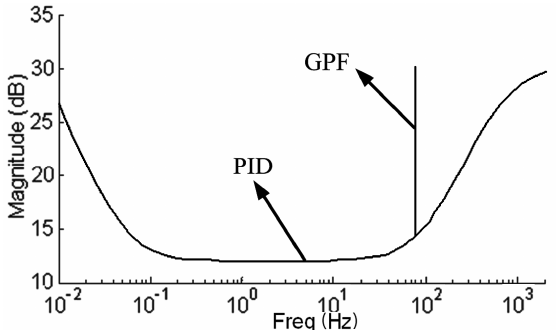
Figure 10. Amplitude-frequency response characteristic of the controller (GPF +